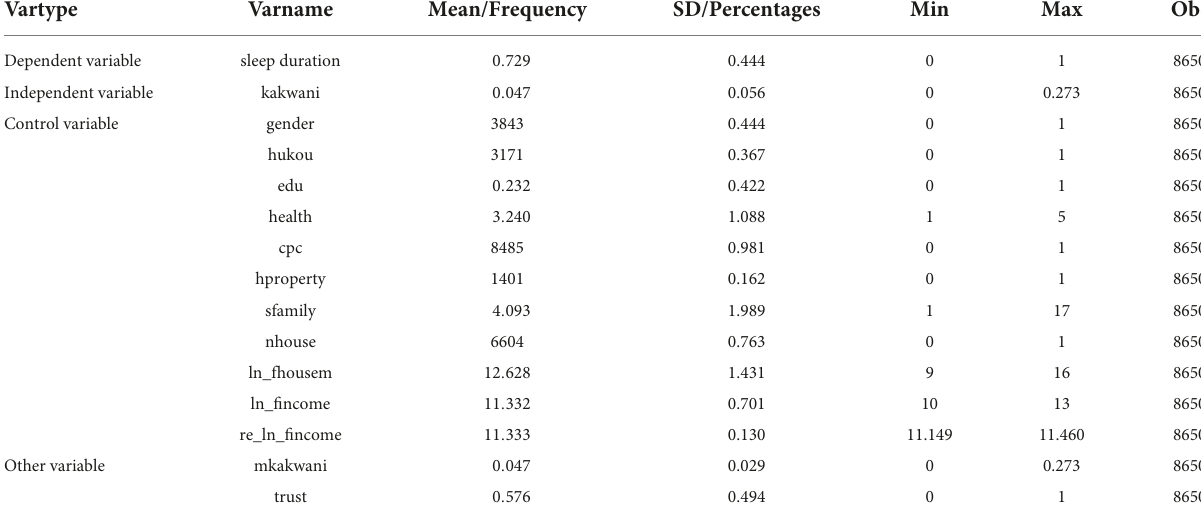
TABLE 1 Key variable description